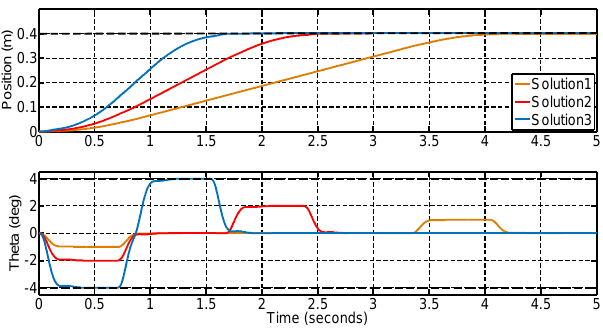
Figure 6. The response of three kinds of solutions. Table 3. Performance of three solutions. ITAE: integration of the time-weighted absolute value of the errors.